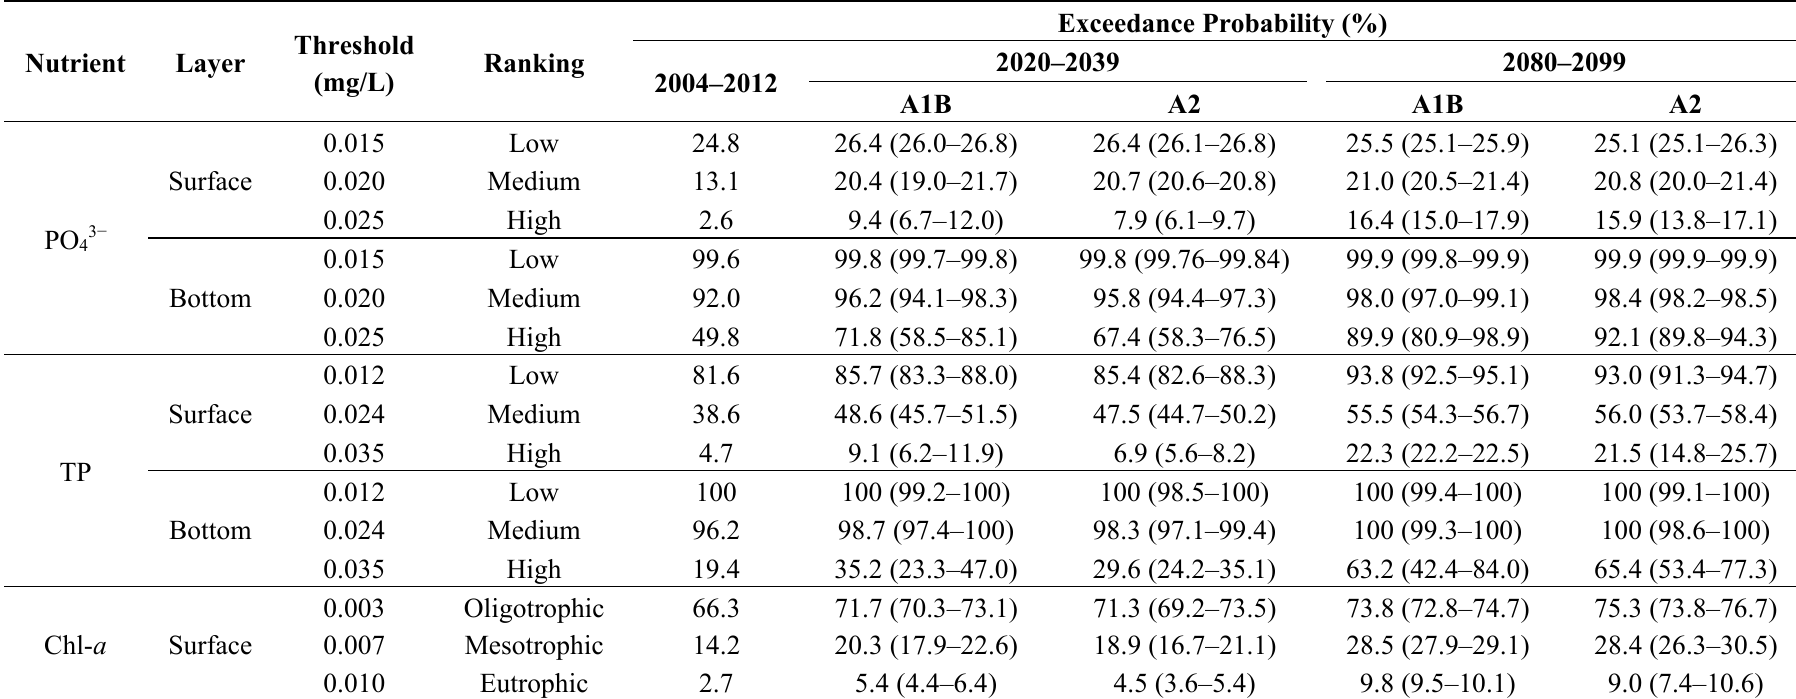
Note: The values in brackets (left to right) are confidence interval lower and upper bounds,